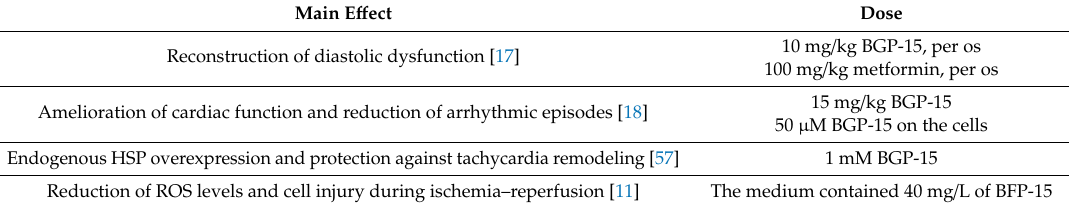
Table 2. Summary of investigations related to the cardiovascular e ff ects of BGP-15.